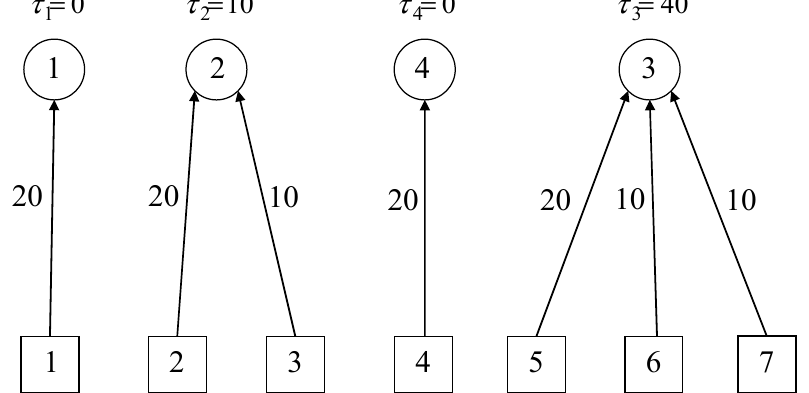
Figure 5. The optimal order-lot matching for Example 2.